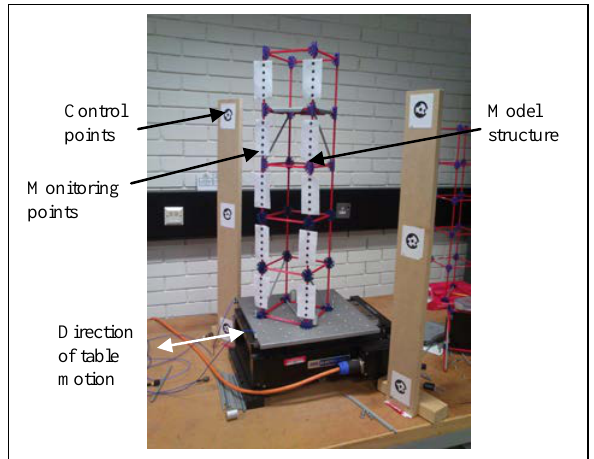
Figure 3. Unresolved measurement matching produced two possible motion vectors.